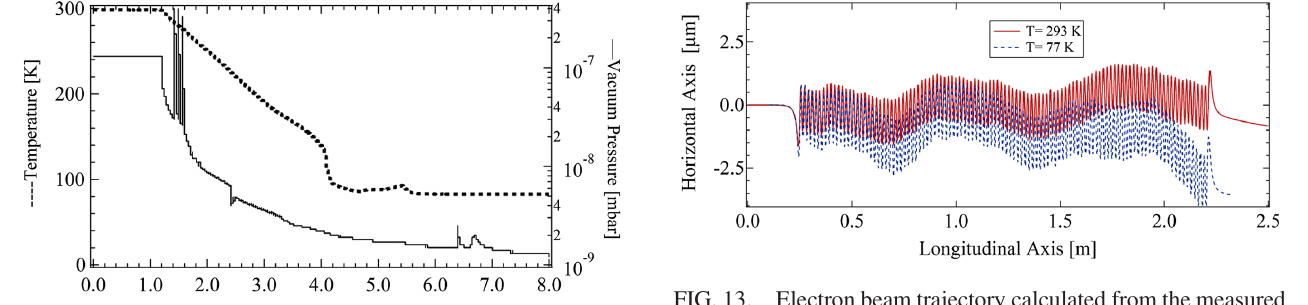
FIG. 13. Electron beam trajectory calculated from the measured magnetic field. (Line) At room temperature 293 K, (dashed) at cryogenic temperature 77 K after rod length correction.